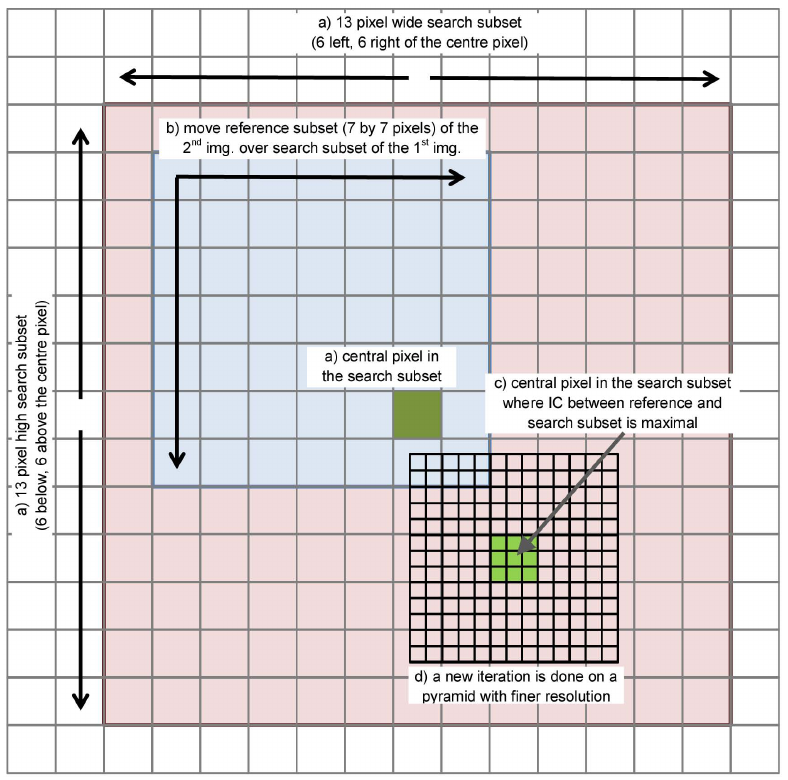
Fig. 4. Refinement of shifts using image pyramids. For more details see